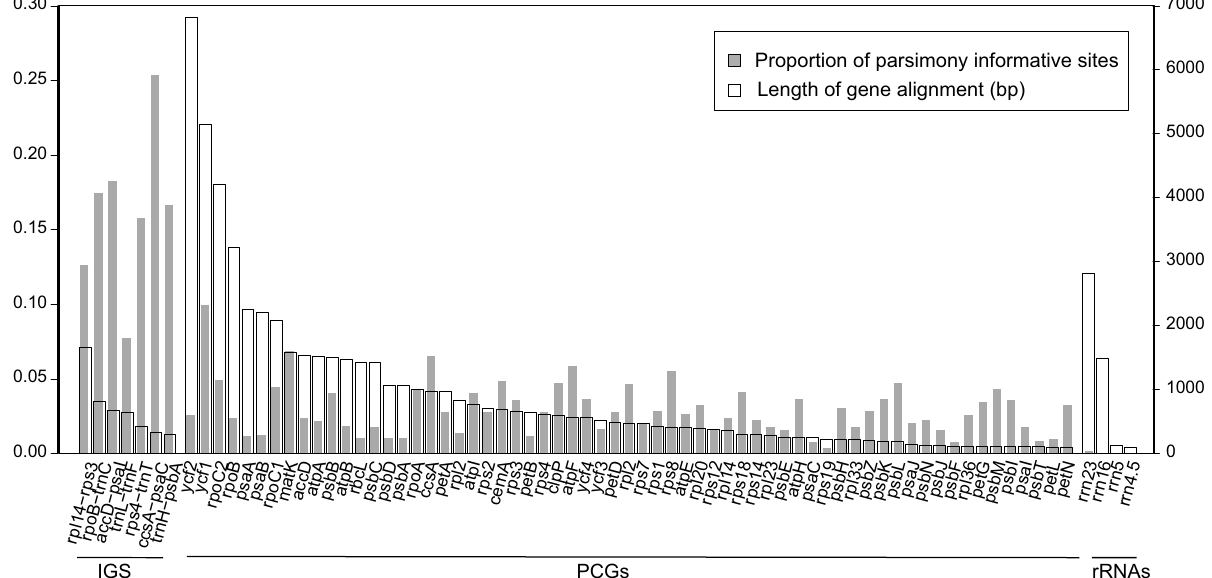
Fig 4. Proportion of parsimony informative sites and gene lengths for 29 Taxillus plastomes. Intergenic spacer regions (IGS), protein coding genes (PCG) and rrn genes (rRNA) are plotted by length (empty vertical bars, length from the sequence alignment) and proportion of parsimony informative sites (vertical filled